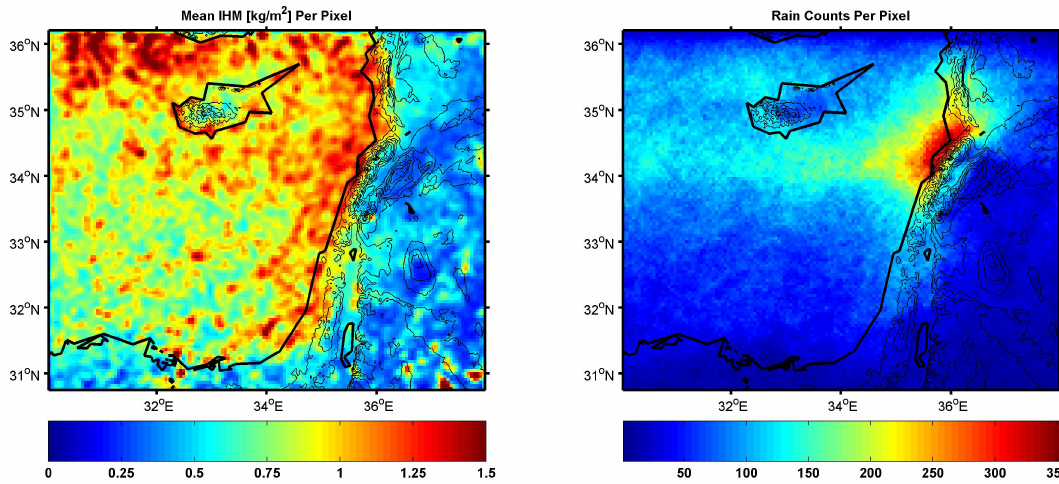
Fig. 4. Left: mean IHM (kgm − 2 ) per pixel. Right: Rain counts per pixel detected by TRMM. Data includes EM winter seasons 1998–2011. Black topography contours with vertical resolution of 300m are added. We focus the study on the high IHM values seen near EM eastern